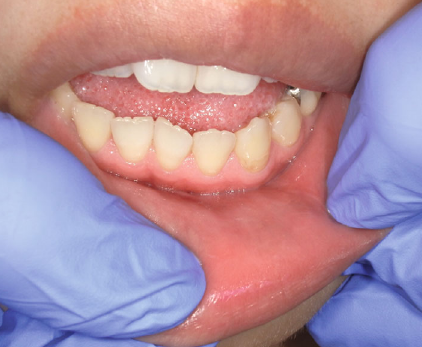
Figure 5: Intraoral fi nding 10 months after the surgery. The wound 10 months after surgery. No recurrence was